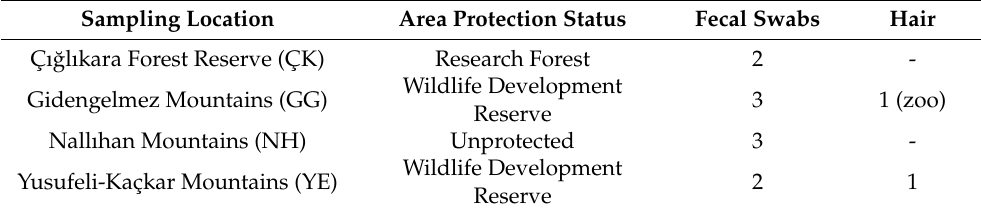
Table 1. Numbers and types of samples included in this study per study site. Sampling